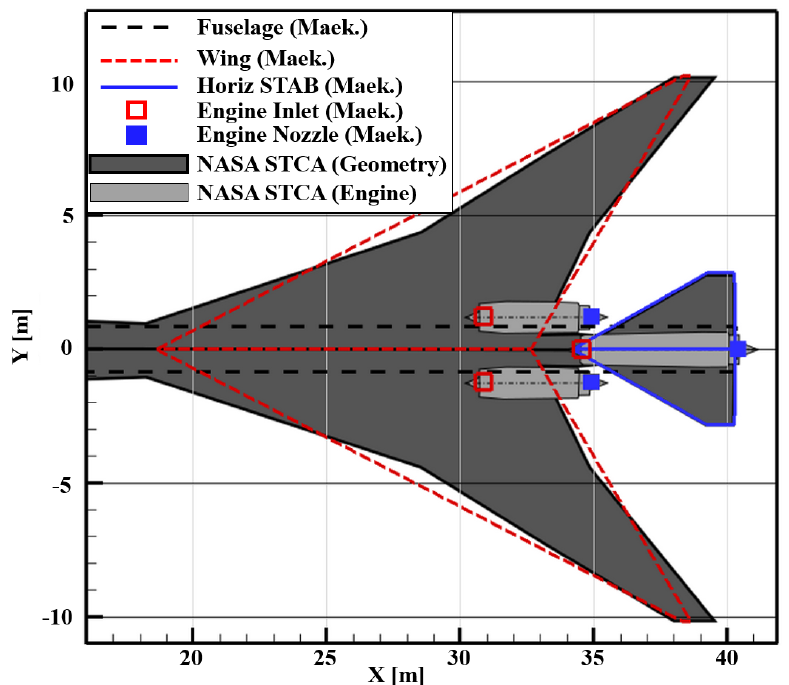
Figure 3. Representation of NASA 55t STCA as input for the noise shielding